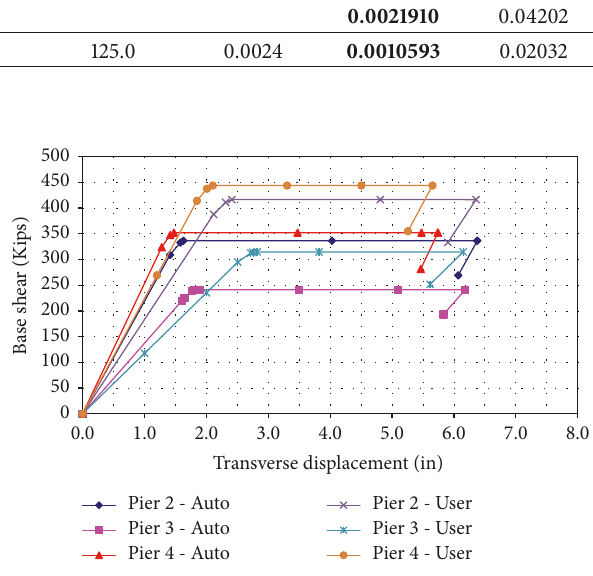
Figure 7: Transverse pushover capacity curve of Bridge #3-E.